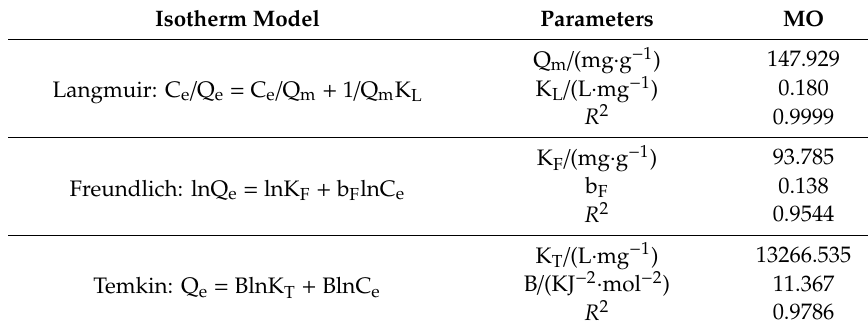
Table 2. Adsorption isotherm parameters for the adsorption of MO onto the PANI / PSMA at pH 4.0 and 25 ◦ C. The contact time was 360